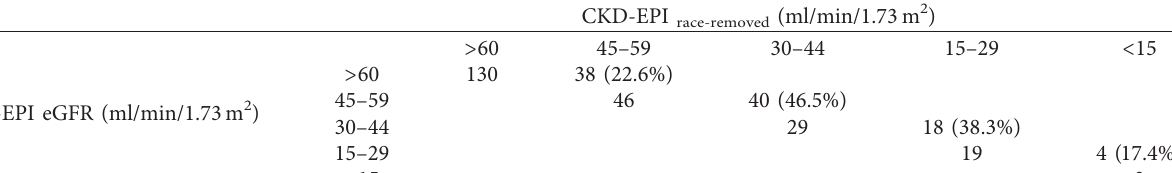
race-removed formulas.